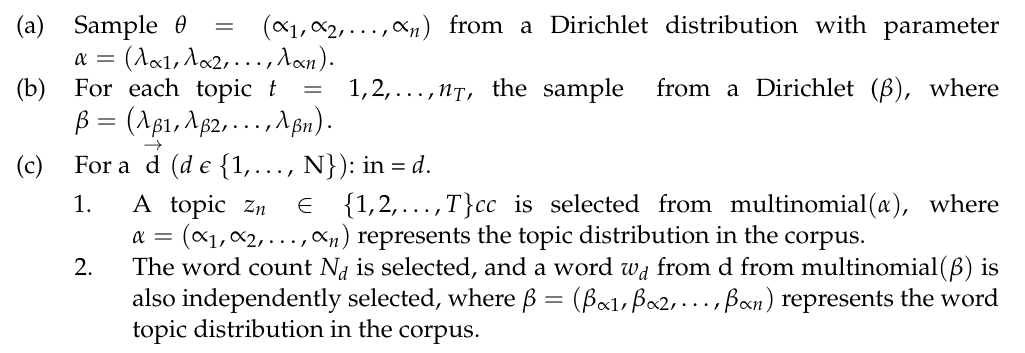
Figure 10. Graphical model illustration for DDM.